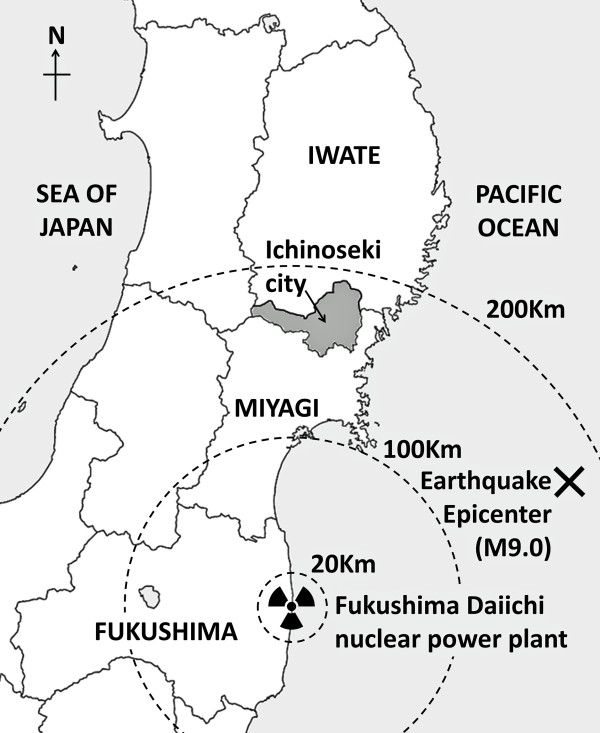
The northeast (Tohoku region) of Japan and the location of Ichinoseki city.